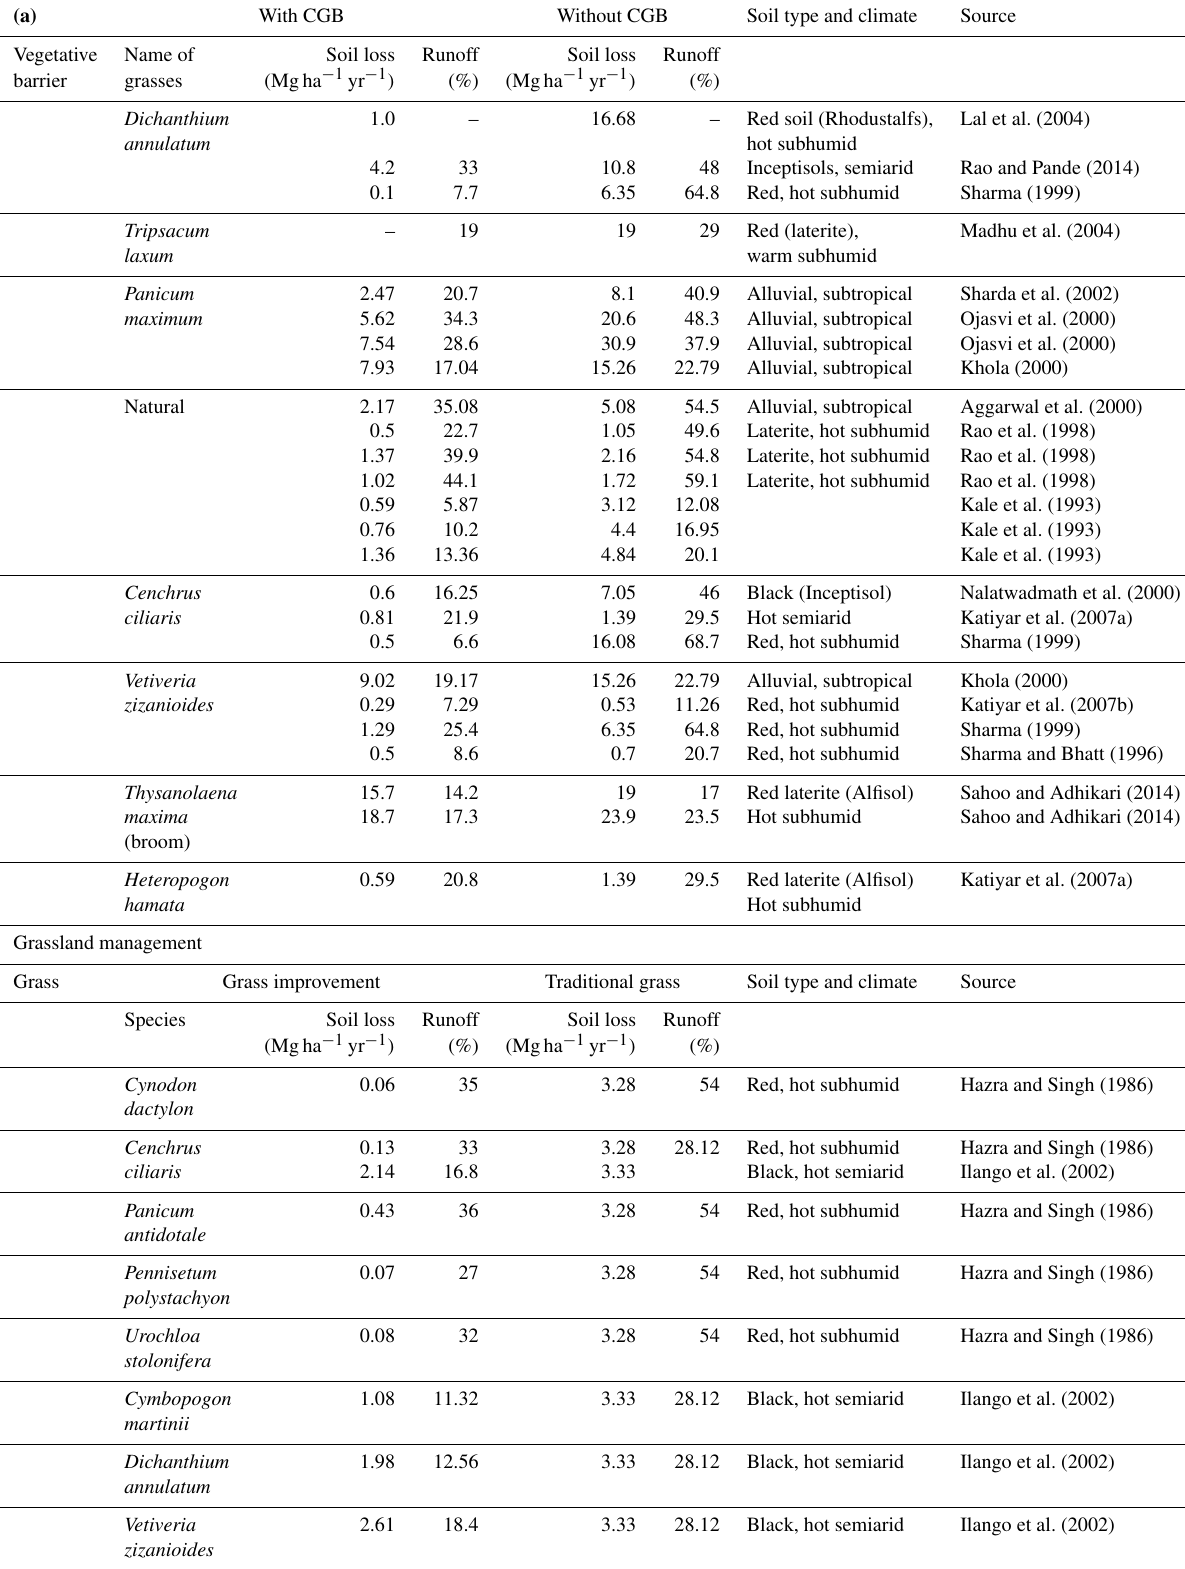
Table 1. (a) Details of the experiments and sources of data used in the study. (b) Details of the experiments and sources of data used to assess relative merits of different contour grass barriers